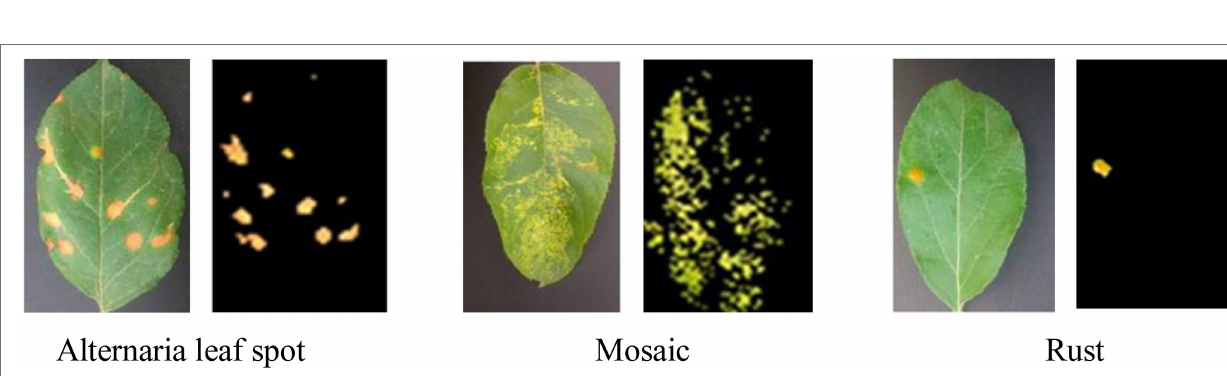
FIGURE 6 | Apple diseased leaf images and augmented images. (A) Original leaves of Alternaria leaf spot disease. (B) Original leaves of Mosaic disease. (C) Original leaves of Rust disease. (D) Twenty-four augmented images of one image.